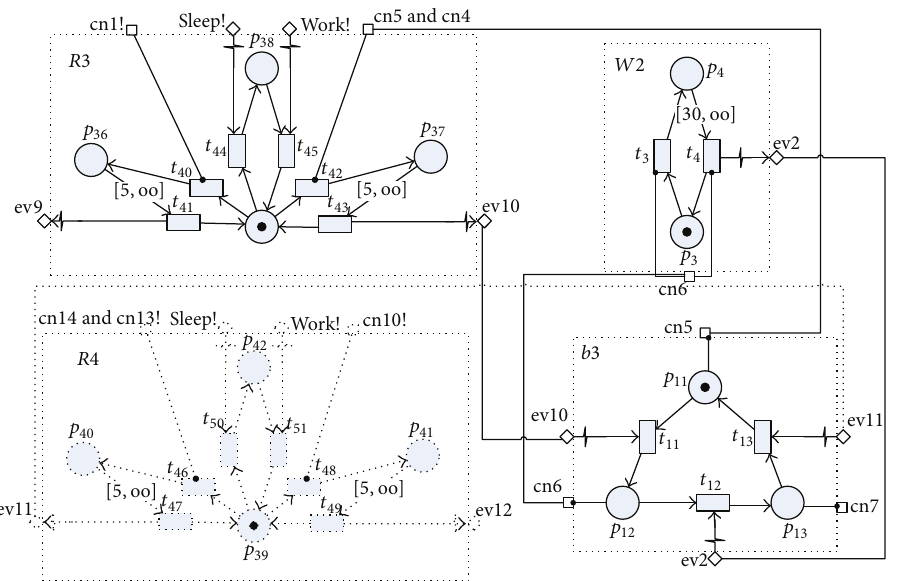
Figure 3: TNCES-based model of 𝑅 3, 𝑅 4, and 𝑊 2 in Mode 1.